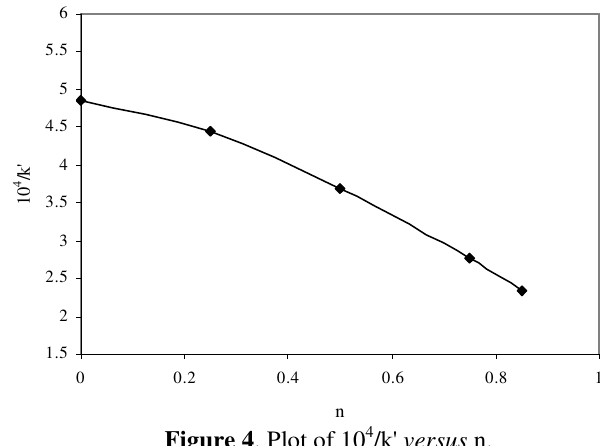
Figure 4 . Plot of 10 4 /k' versus